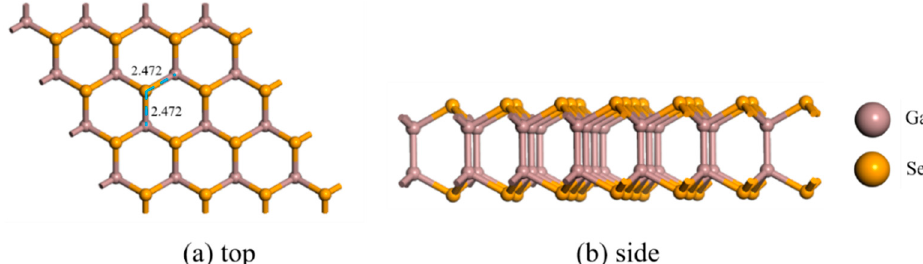
Figure 2. Geometric model of GaSe monolayer.